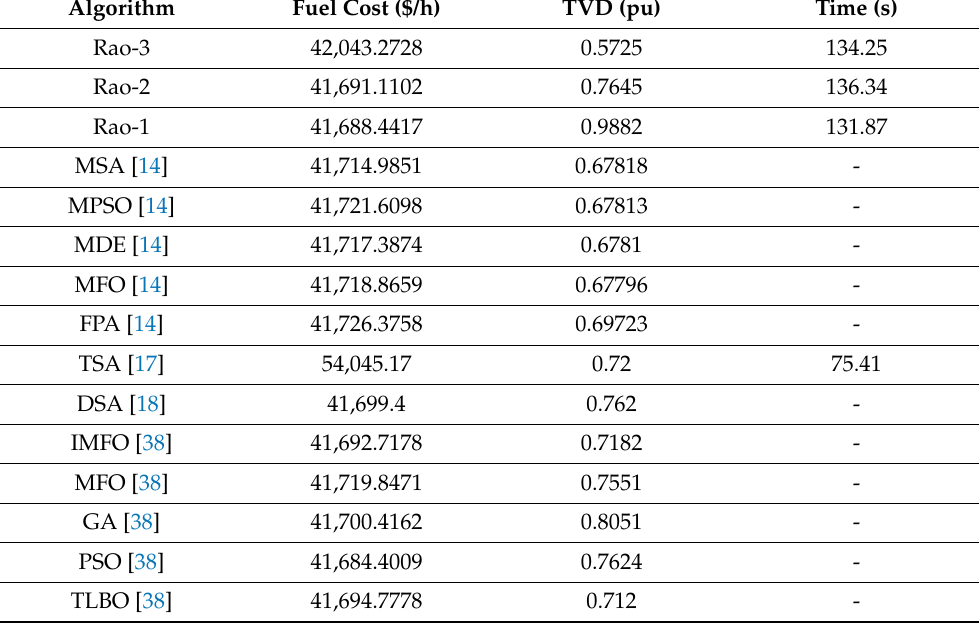
Table 13. Case 8: VPI results in the IEEE 57-bus